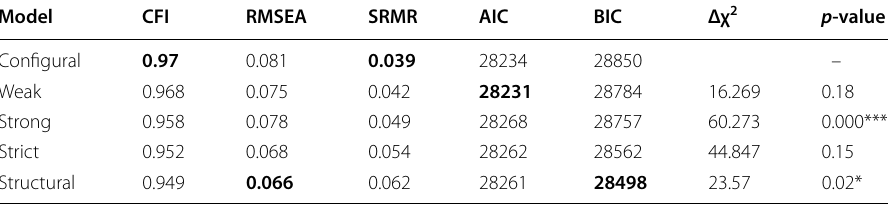
Δχ 2 is the change in chi-square from the one model above to the current reduced model. The bold values indicate the best fit among models under the fit indices. *** p ≤